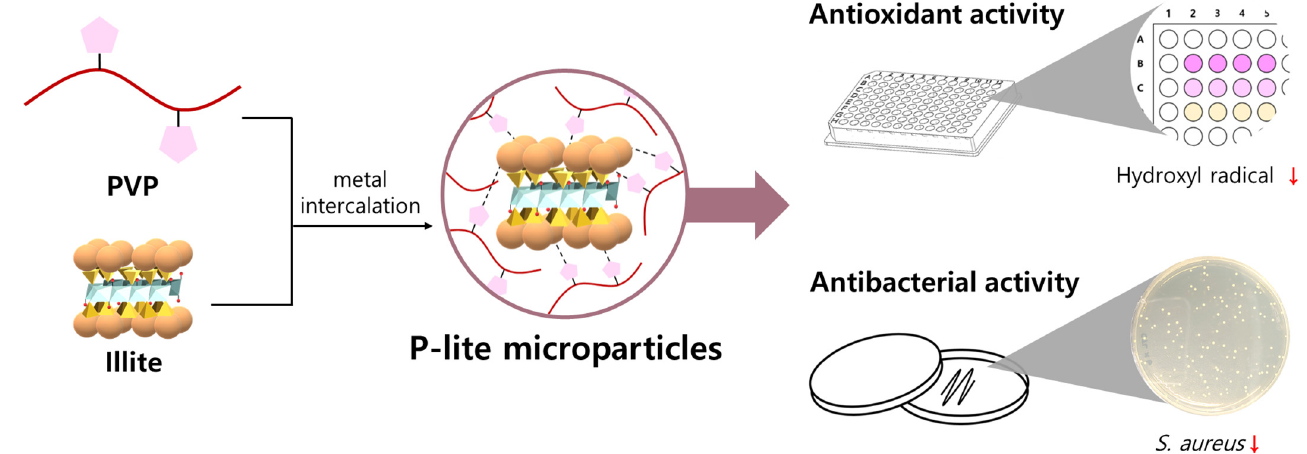
Figure 1. Schematic preparation of PVP-stabilized illite microparticles. PVP, polyvinylpyrrolidone; P-lite, PVP-stabilized illite; S. aureus , Staphylococcus aureus .